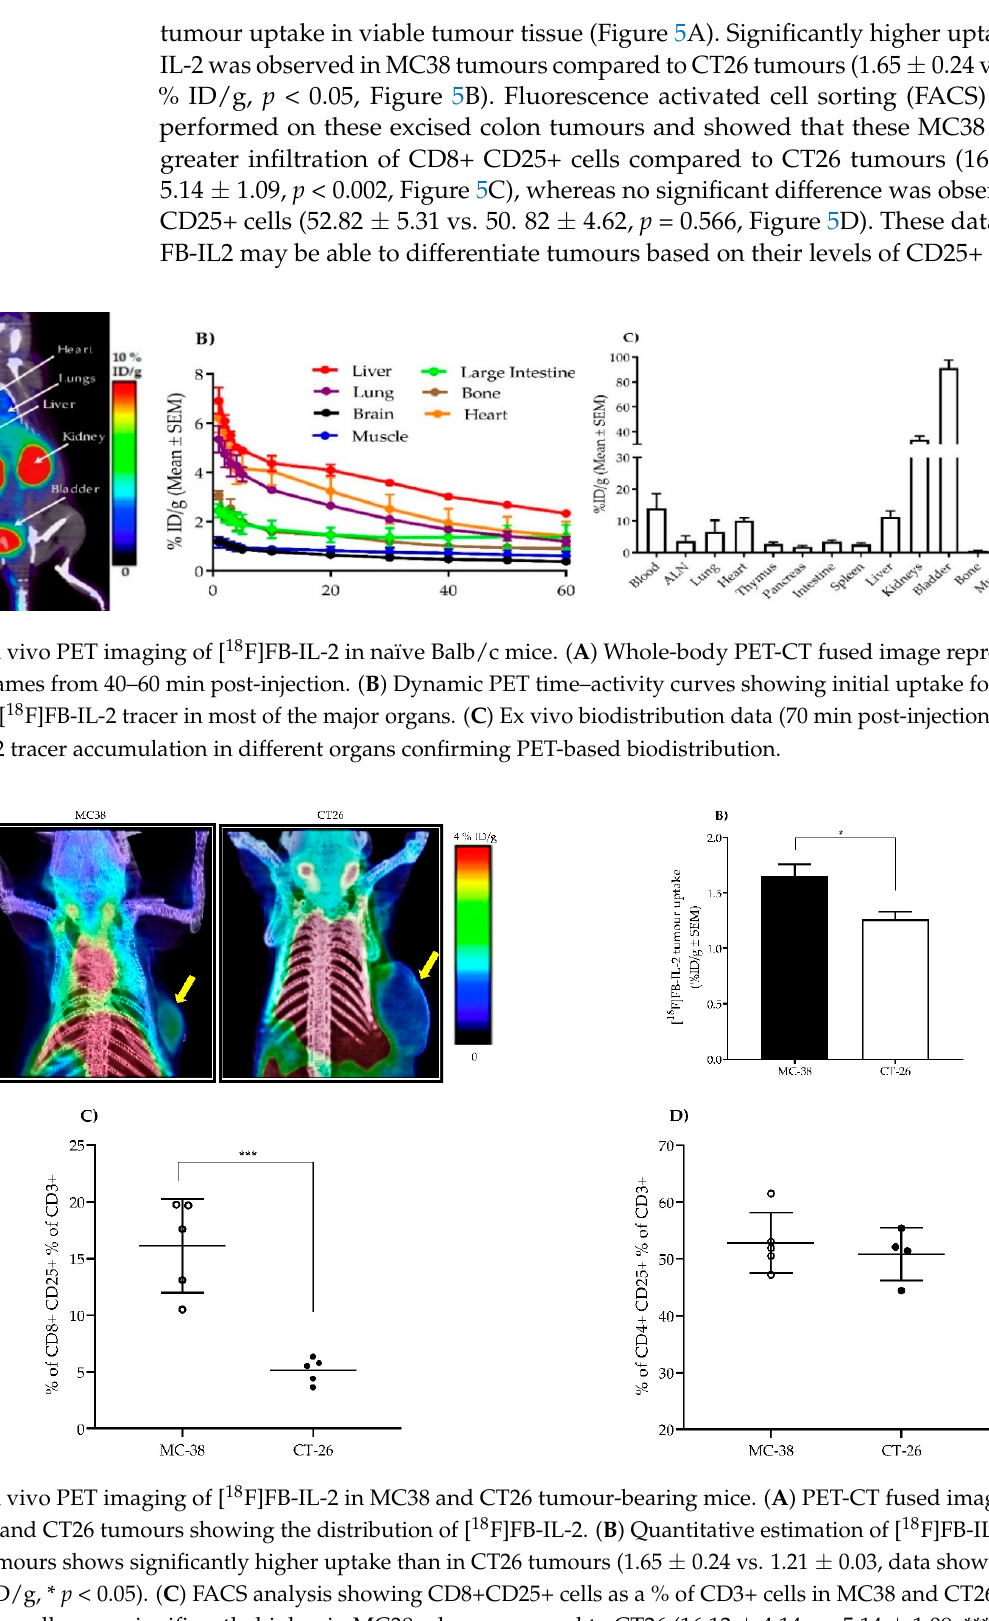
Figure 5. In vivo PET imaging of [ 18 F]FB-IL-2 in MC38 and CT26 tumour-bearing mice. ( A ) PET-CT fused image of mice with MC38 and CT26 tumours showing the distribution of [ 18 F]FB-IL-2. ( B ) Quantitative estimation of [ 18 F]FB-IL-2 uptake in MC38 tumours shows significantly higher uptake than in CT26 tumours (1.65 ± 0.24 vs. 1.21 ± 0.03, data shown as mean ± SEM % ID/g, * p < 0.05). ( C ) FACS analysis showing CD8+CD25+ cells as a % of CD3+ cells in MC38 and CT26 tumours. CD8+CD25+ cells were significantly higher in MC38 when compared to CT26 (16.12 ± 4.14 vs. 5.14 ± 1.09, *** p < 0.002, data